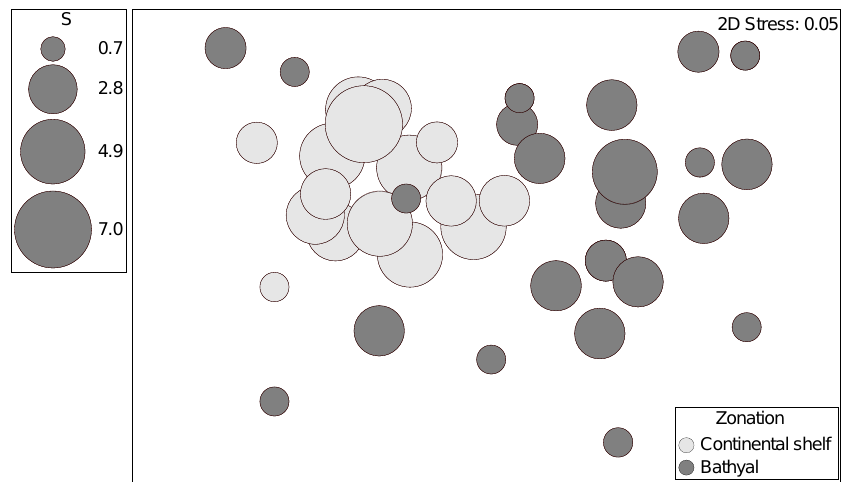
Figure 6. Non-Metric Multidimentional Scaling (nMDS) based on Sørensen dissimilarities among sites on the continental shelf (<200 m) and bathyal zone (>200 m) of the PFB, northwest Gulf of Mexico. The size of the circles indicates the number of species registered at each site.